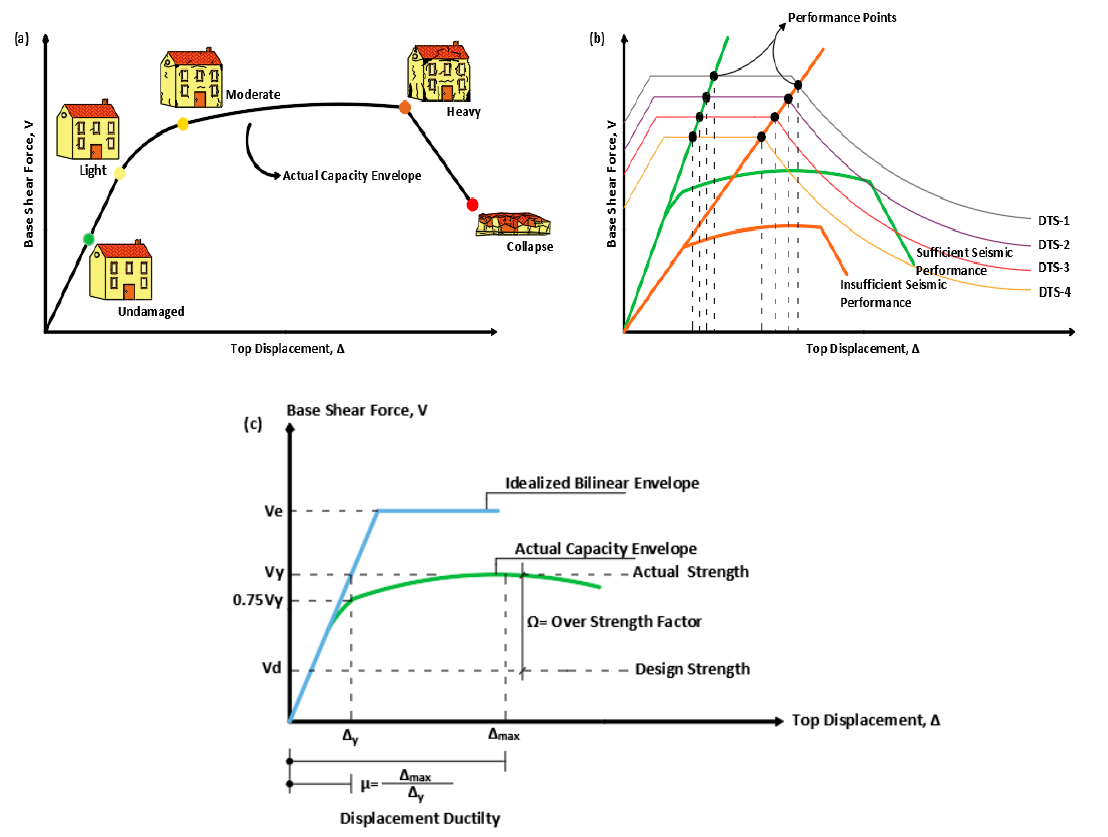
Figure 8. Lateral load–top displacement curve under earthquake and determination of perfor- mance point: ( a ) building performance levels; ( b ) comparison of capacity curves; ( c ) V d /V y